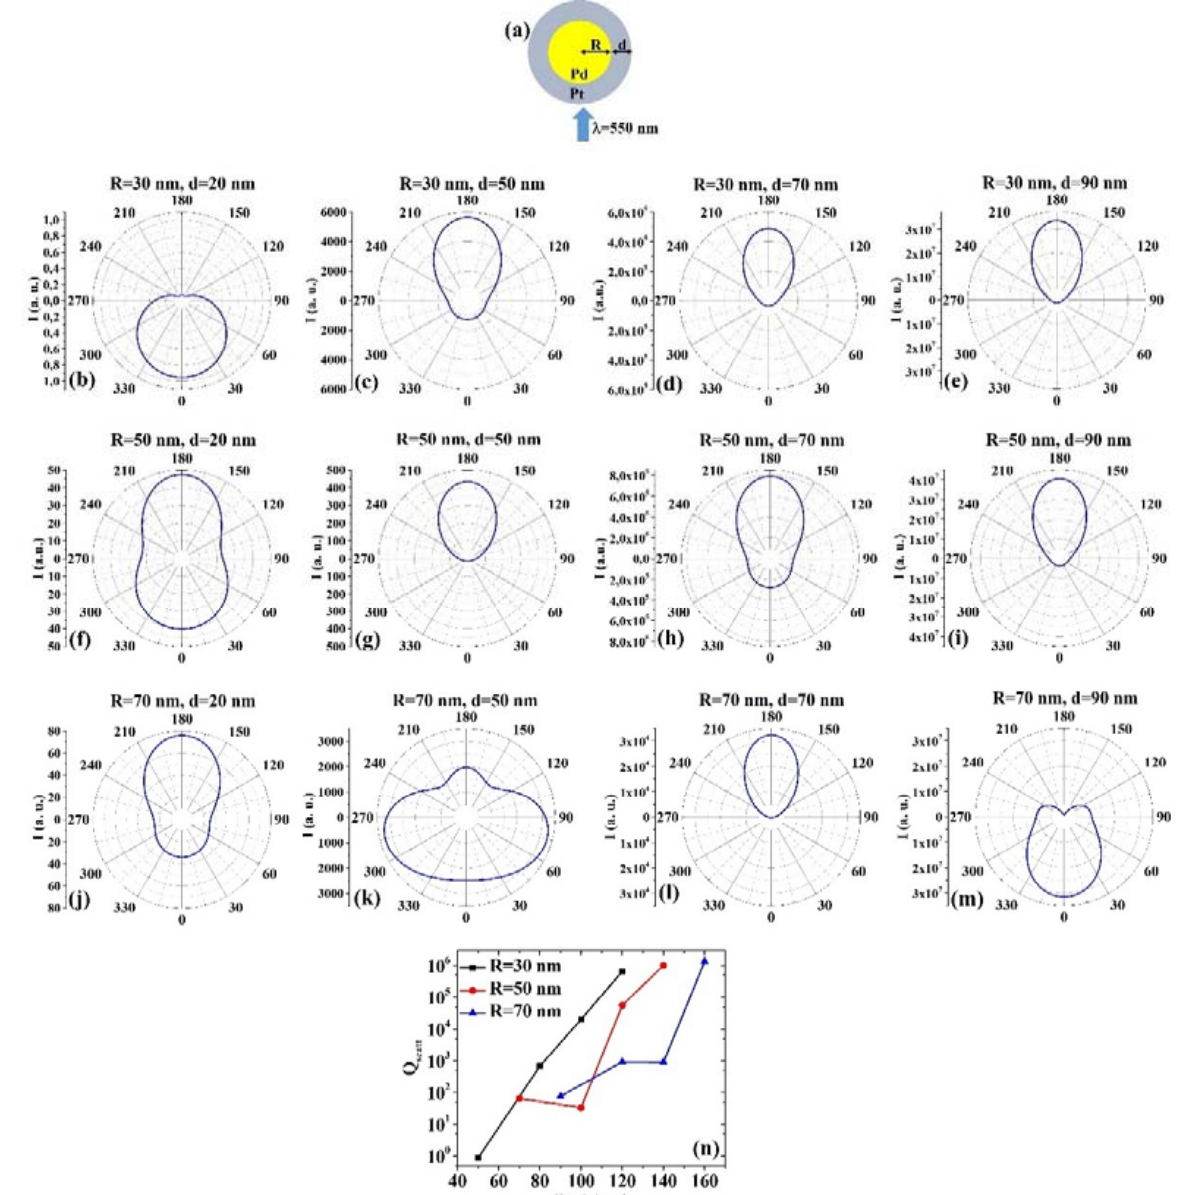
Figure 9. ( a ) Scheme of the structure of the simulated Pd/Pt core/shell spherical particle with core radius R and shell width d and electromagnetic radiation of wavelength λ = 550 nm impinging on the particle from 0°. ( b – m ) Calculated polar diagrams for the intensity of the scattered light from the Pd/Pt core/shell spherical particle changing the Pd core radius R and the Pt shell width: ( b – e ) R = 30 nm and d = 20 nm ( b ), d = 50 nm ( c ), d = 70 nm ( d ), d = 90 nm ( e ); ( f – i ) R = 50 nm and d = 20 nm ( f ), d = 50 nm ( g ), d = 70 nm ( h ), d = 90 nm ( i ); ( j – m ) R = 70 nm and d = 20 nm ( j ), d = 50 nm ( k ), d = 70 nm ( l ), d = 90 nm ( m ). ( n ) Calculated scattering efficiency for the light (wavelength λ = 550 nm) scattering process of the Pd/Pt spherical particle fixing the Pd core diameter (R = 30 nm black dots, R = 50 nm red dots, R = 70 nm blue dots) and increasing the Pt shell width d from 20 nm to 90 nm.